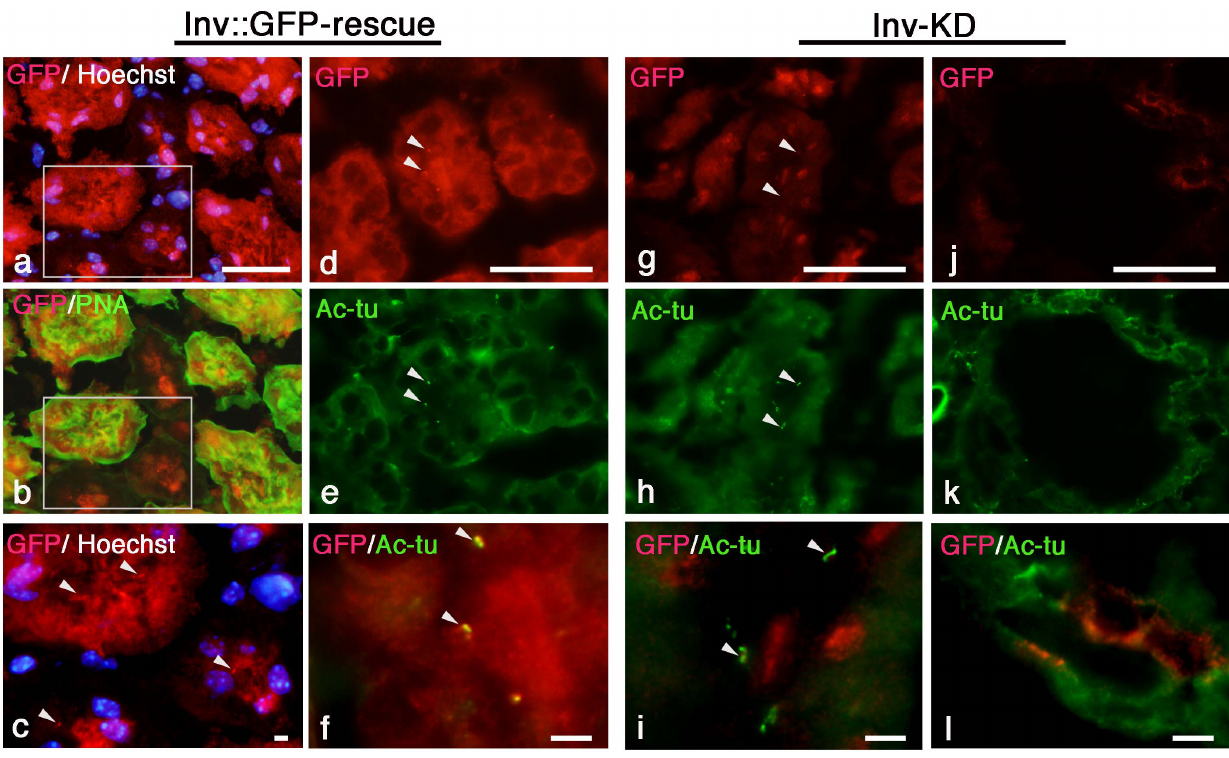
Figure 4. Down-regulation of Inv::GFP protein in Inv-KD mouse kidneys. Cross sections prepared from adult (12 month-old) kidneys of Inv- KD mice (g–l) and control Inv::GFP-rescue mice (a–f) were double-stained with anti-GFP antibodies (a–c, red) and PNA-FITC (b, green) or anti-GFP (d, g and j, red) and anti-acetylated tubulin antibodies (e, h and k, green). Nuclei were counterstained with Hoechst dye (a and c). High magnification image of the boxed region (a and b) are shown in panel (c). Merged and high magnification image of (de, gh and jk) are shown in panel (f, i and l) respectively. Inv::GFP protein was detected in proximal (PNA-negative) and distal (PNA-positive) tubules of Inv::GFP-rescue mice (a and b). Localization of Inv::GFP protein was detected in the cilia of both proximal and distal tubules (c, arrowhead).Inv::GFP protein was specifically down- regulated in the renal tubules of Inv-KD mice (g and j) compared with Inv::GFP-rescue mice (a and d). Inv::GFP fusion proteins were localized in the proximal region of anti-acetylated tubulin positive cilia of the renal tubules of Inv::GFP-rescue mice (d–f, arrowheads), but were down-regulated in Inv-KD mice (g–i, arrowheads). Inv::GFP protein was significantly down-regulated in the cystic tubules (j–l) compared with the non-cystic tubules (g–i). Images were taken at 10 6 40 (a and b) and 10 6 60 (d, e, g, h, j and k) magnification. Scale bars: 50 m m (a, d, g and j); 5 m m (c, f, i and l).